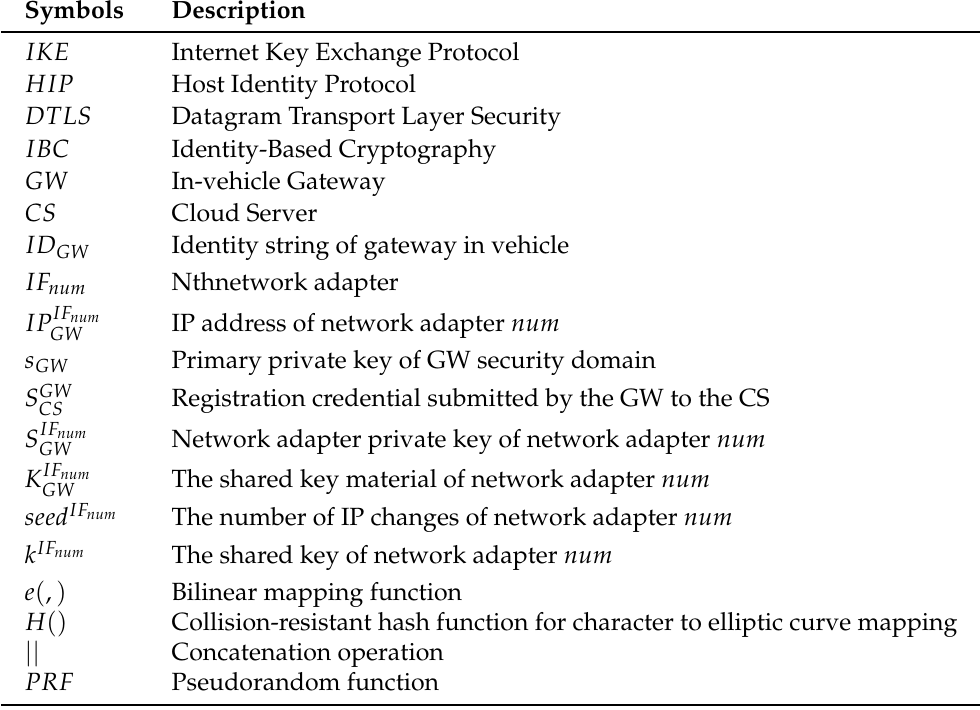
Table 2. Summary of